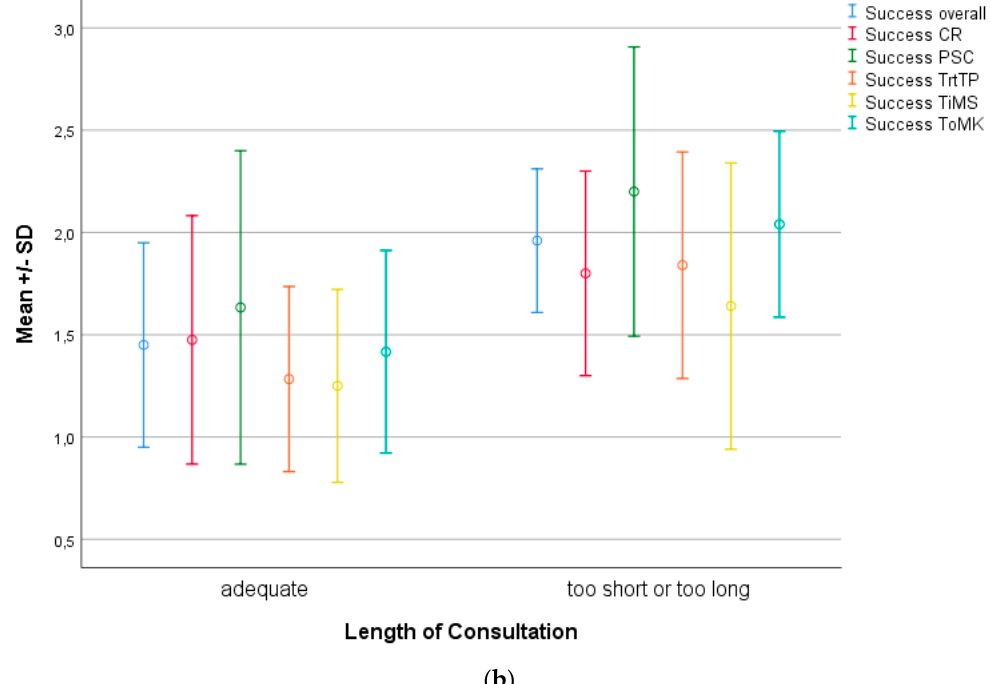
Figure 1. ( a ) Overall Counselling Success differentiated according to whether the length of the consultation was perceived as appropriate or not. The columns show the number of nominations. ( b )